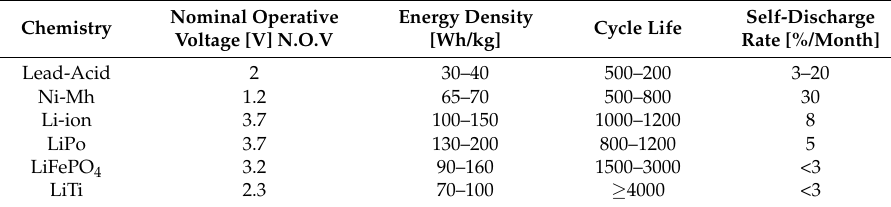
Table 5. Battery Package Comparison [80].